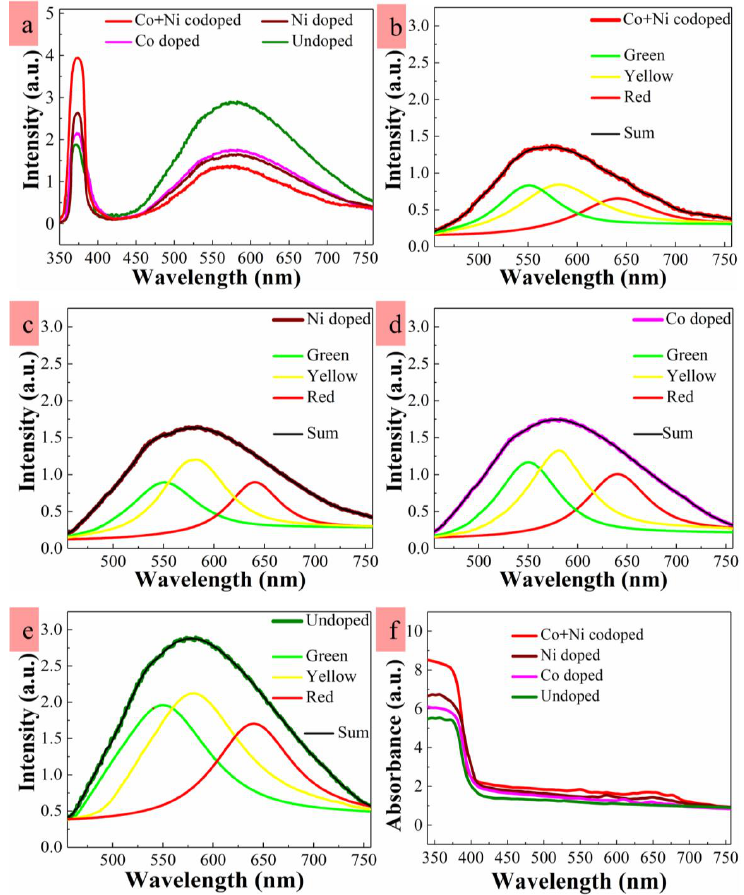
Figure 4. ( a ) Photoluminescence (PL) spectra of the NRs measured at room temperature and deconvoluted visible emission spectra of the NRs grown with ( b ) Co-plus-Ni doping, ( c ) Ni doping, ( d ) Co doping, and ( e ) no doping. Ultraviolet (UV)/visible spectra of the NRs measured at room temperature ( f ).